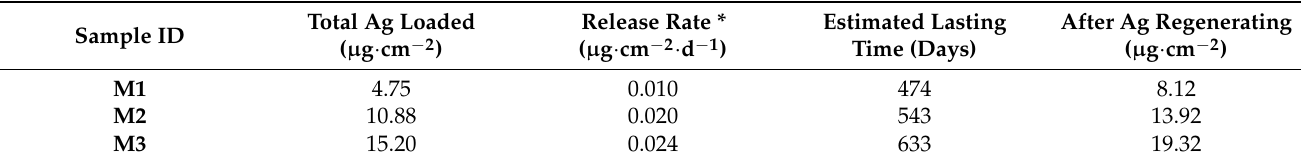
Table 3. The Content of Silver Loaded on the Membrane Surface Determined by ICP-OES and Estimated Time of Silver Release from the Membranes.